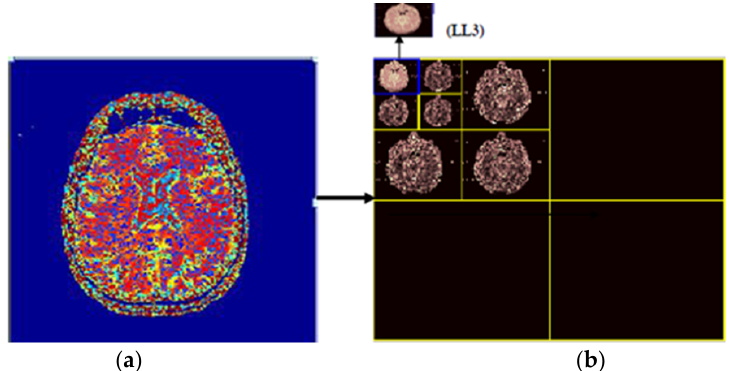
Figure 7. ( a ) original image, ( b ) 3 levels decomposition by using Harr wavelet.